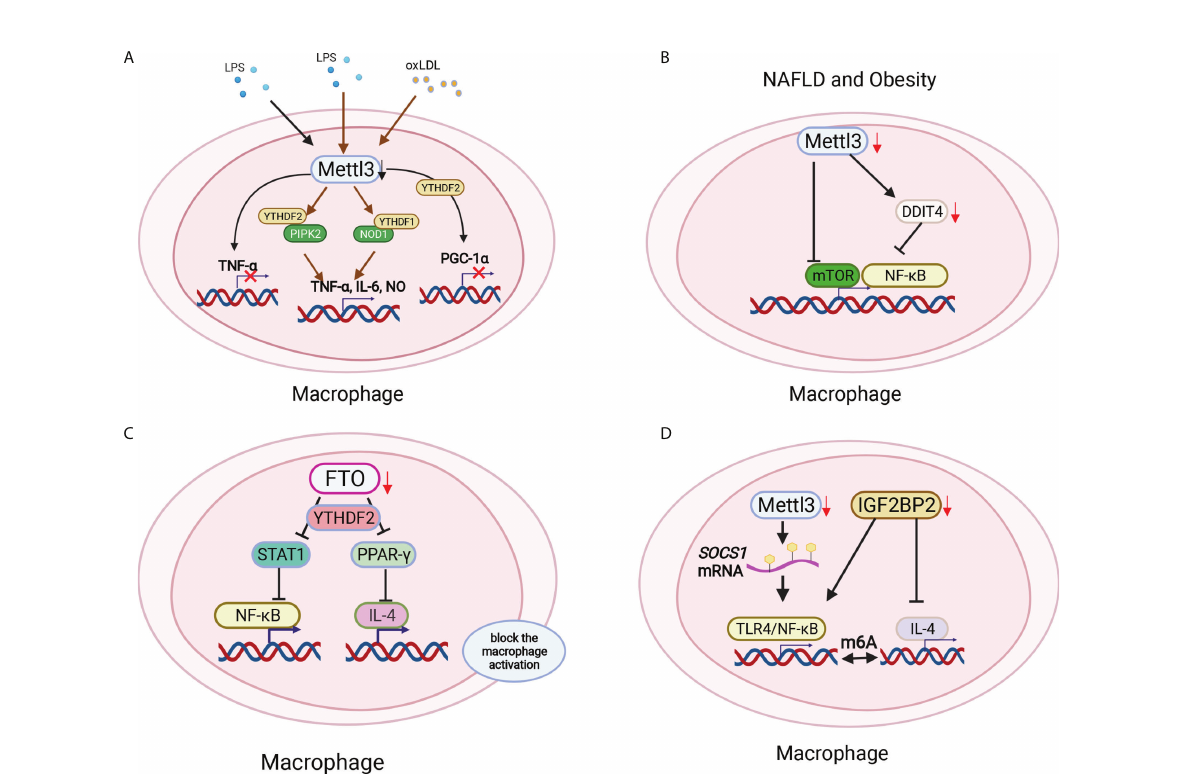
FIGURE 4 Macrophage polarization was modi fi ed by m6A methylation in different environments. (A) Mettl3 ablation macrophages produced little TNF- a with LPS stimulation. Mettl3 downregulation in macrophages signi fi cantly increased the proin fl ammatory cytokines TNF- a , IL-6 and NO by increasing NOD1 and RIPK2 via YTHDF1 and YTHDF2, respectively. Mettl3 and YTHDF2 cooperatively degraded PGC-1 a mRNA in oxLDL-treated monocytes. (B) Myeloid lineage-restricted Mettl3 deletion protected mice from age-related and diet-induced development of innate immunity- driven nonalcoholic fatty liver disease (NAFLD) and obesity by decreasing mTOR expression and the NF- k B pathway by targeting DDIT4. (C) FTO de fi ciency inhibited both M1 and M2 polarization by suppressing the NF- k B signaling pathway and decreasing the stability of STAT and PPAR- g via YTHDF2 involvement, therefore blocking macrophage activation. (D) The loss of Mettl14 decreased the demethylase Socs1 mRNA to activate TLR4/NF- k B signaling. In addition, IGF2BP2 -/- macrophages were refractory to IL-4-induced activation to regulate the switch of M1 to M2 subtypes in a m6A-dependent